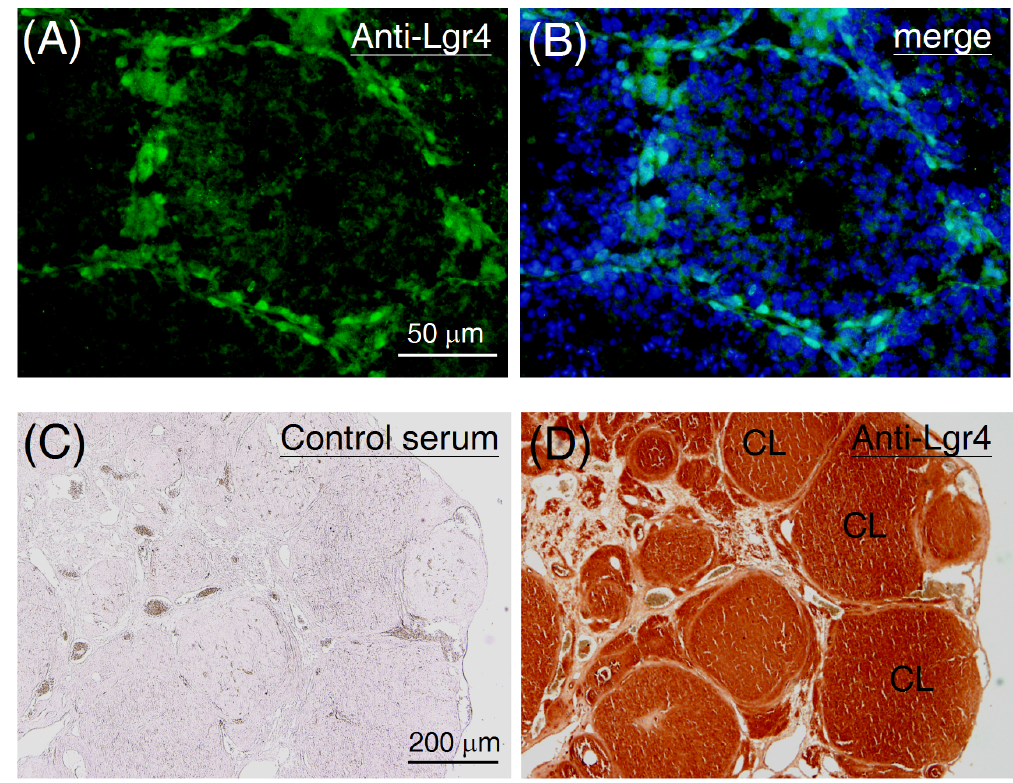
Figure 5. Distribution of the Lgr4 protein in the postnatal gonads. To assess the testicular distribution of Lgr4, testicular sections from mice at 5 weeks old were probed with the anti-Lgr4 antibody followed by fluorescein isothiocyanate-conjugated secondary antibody. Data are shown in parallel without (A) or with (B) a DAPI merged image. To assess the ovarian distribution of Lgr4, ovarian sections from mature rats (8 weeks old) were probed either (C) with preimmune rabbit serum or (D) with the anti-Lgr4 antibody. The sections were then visualized using a horseradish peroxidase system. CL, corpus luteum.